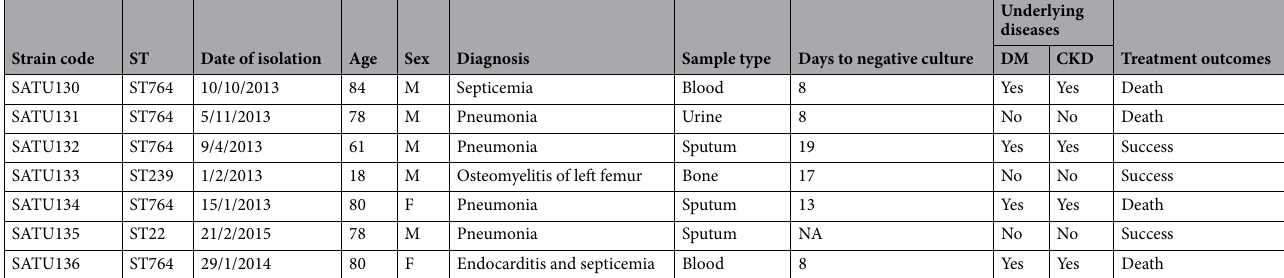
Table 1. Profiles of patients whose MRSA isolates were studied by WGS. WGS whole genome sequencing, ST sequence type, NA not available, DM diabetes mellitus, CKD chronic kidney disease.